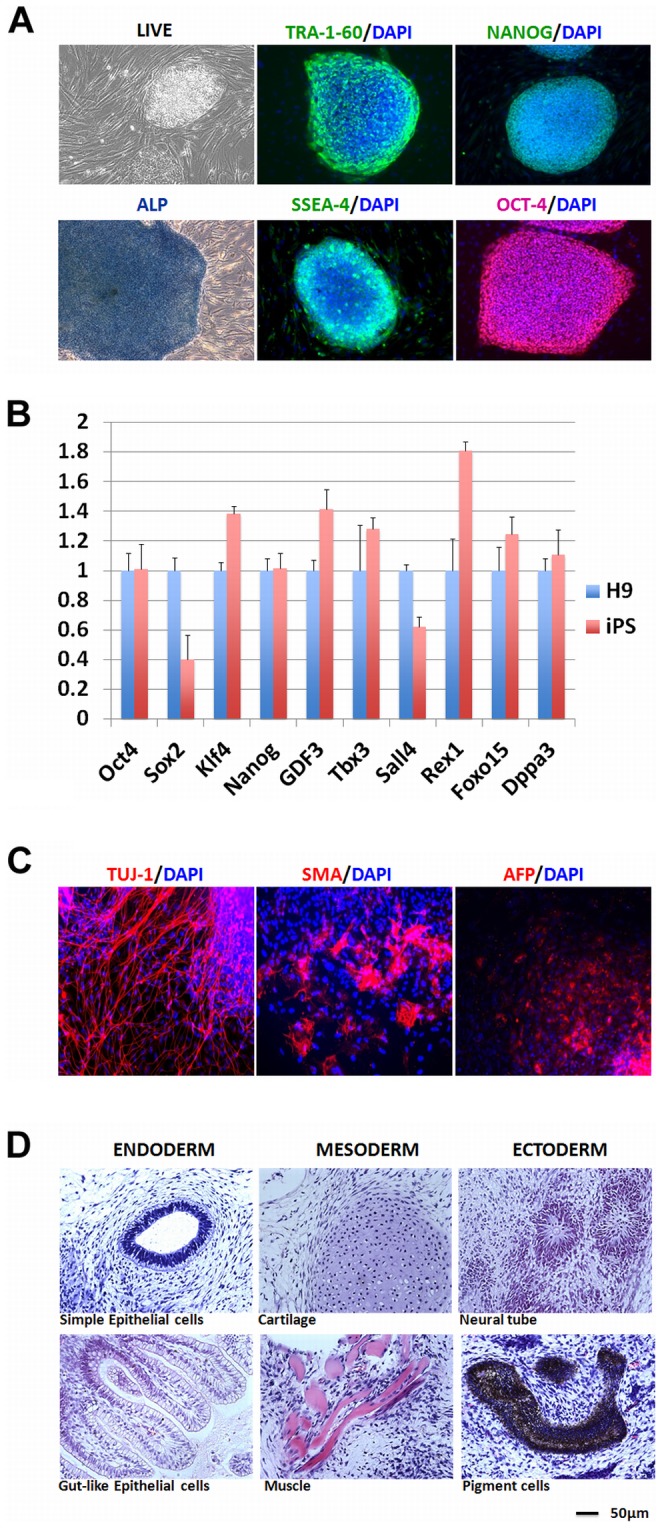
The hiPSCs are fully pluripotent.
A. immunocytochemistry and alkaline phosphatase (ALP) staining for pluripotent markers. Nuclear markers: Oct 4 and Nanog; Surface markers: SSEA-4, Tra-1-60. B. qPCR for various pluripotent genes indicates that hiPSCs are very similar to hESCs H9 in terms of gene expression levels. C.
in vivo differentiation of hiPSCs to three germ layers. Ectoderm marker: TUJ-1; Mesoderm marker: SMA; Endoderm marker: AFP. D. hiPSCs can form teratoma in mouse containing derivatives of all three embryonic germ layers (ectoderm, mesoderm, and endoderm), shown by histopathology staining.